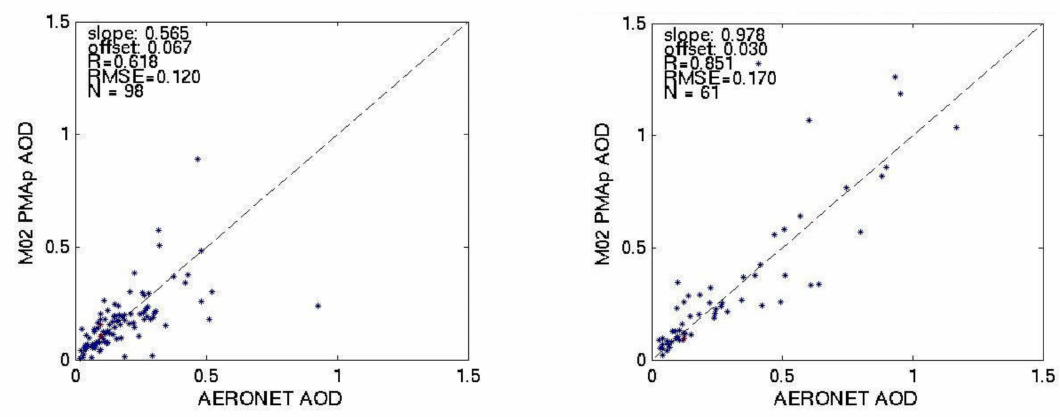
Figure 9. Scatter plot of the comparison of PMAp-A measurements with AERONET over the ocean, and for the validation period 1 in 2013 (left), and 2 in 2015